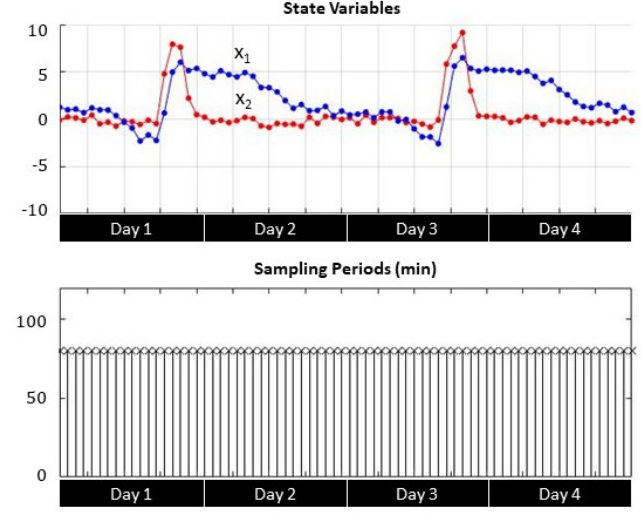
Figure 9. Periodical sampling (h = 80 min) state variable evolution and sampling periods.